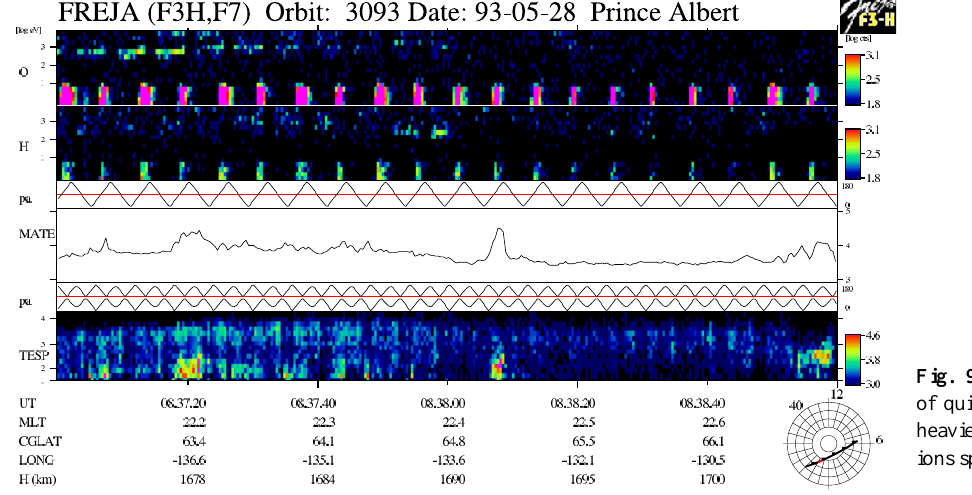
Fig. 9. An example in orbit 3093 of quite narrow energy spectra for the heavier ions and very low fluxes of H + ions spread over a wide energy range.